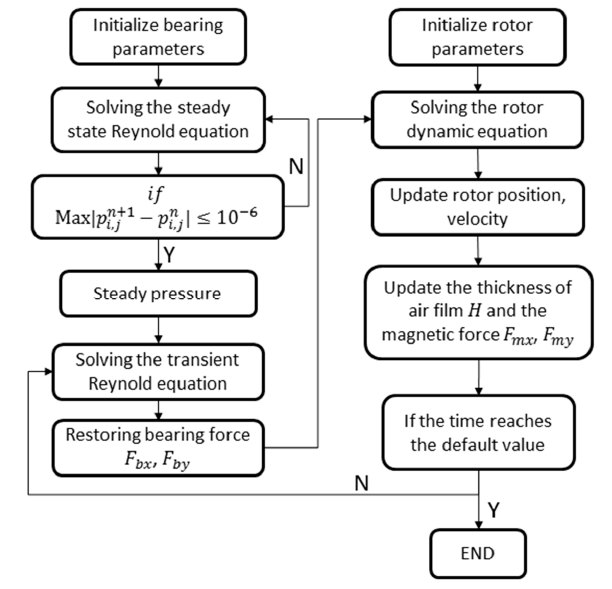
Figure 4. The flow chat for calculating the coupled dynamic equation.